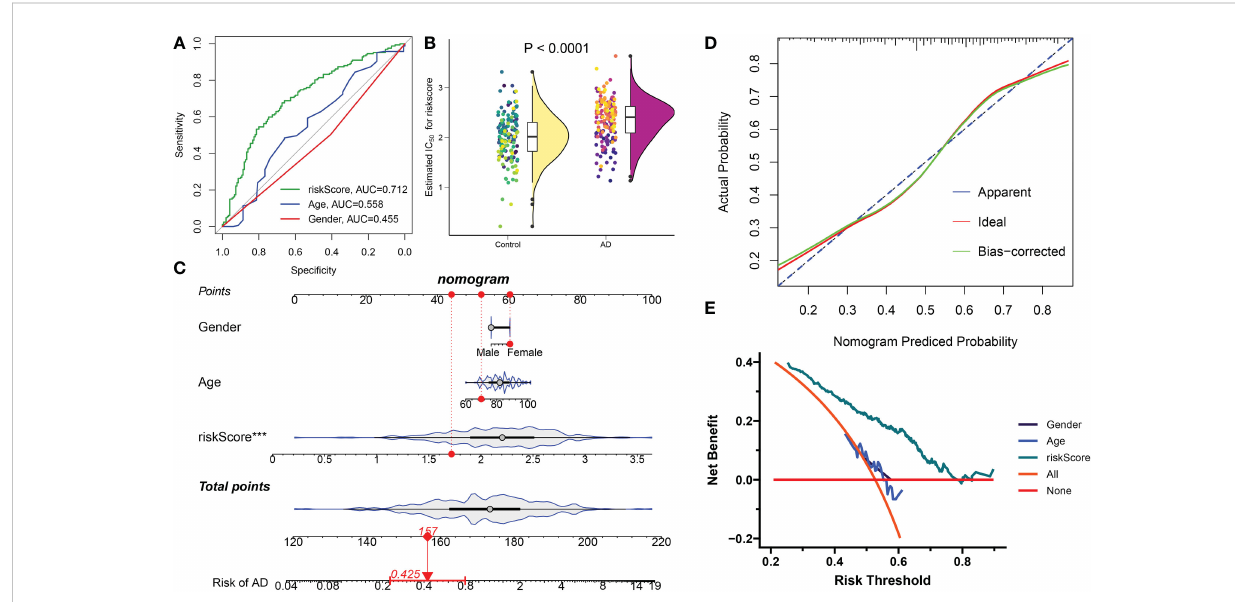
FIGURE 10 Construction and validation the diagnostic ef fi cacy of riskScore. (A) ROC curves displaying the diagnostic ef fi cacy of riskScore and classic clinical indicators in the combined dataset. (B) Comparison of riskScore across AD and normal brain tissues in the combined dataset. (C) Establishment of a predictive nomogram consisting of riskScore, age, and gender. (D) Calibration curve displaying the predicted ef fi cacy of a predictive nomogram. (E) DCA showing the clinical bene fi ts of a predictive